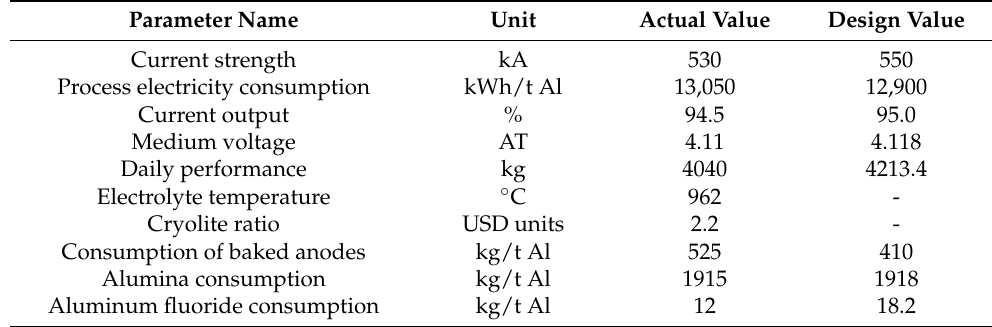
Table 1. Parameters of the dependence of the output power on the temperature of the heat transfer surface of the